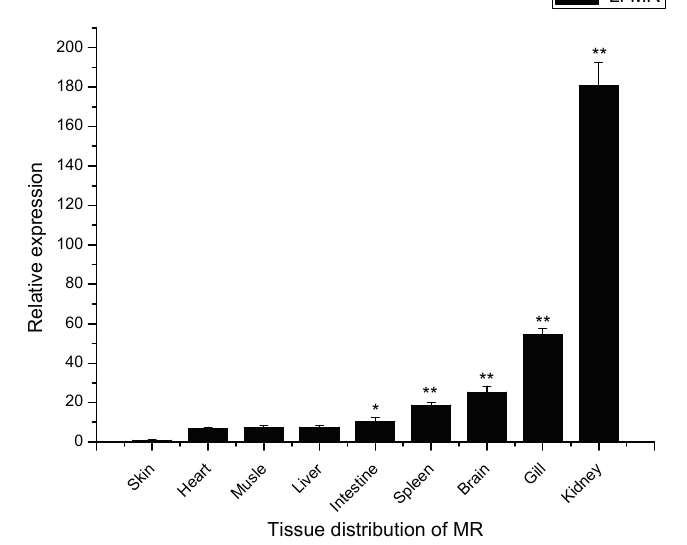
Figure 3. Expression analysis of MR mRNAs in various tissues of zebra fish by Quantitative Real-Time PCR (qRT-PCR). The expression level of MR in the skin was set as 1, expression levels in all other tissues were presented relative to that in the skin. Expression of β -actin was used as an internal control for qRT-PCR. Each experiment was performed in triplicate. Data were shown as mean ± SE ( n = 3). The asterisk indicated a statistically significant difference ( ** p < 0.01, * p < 0.05) compared with skin (set as